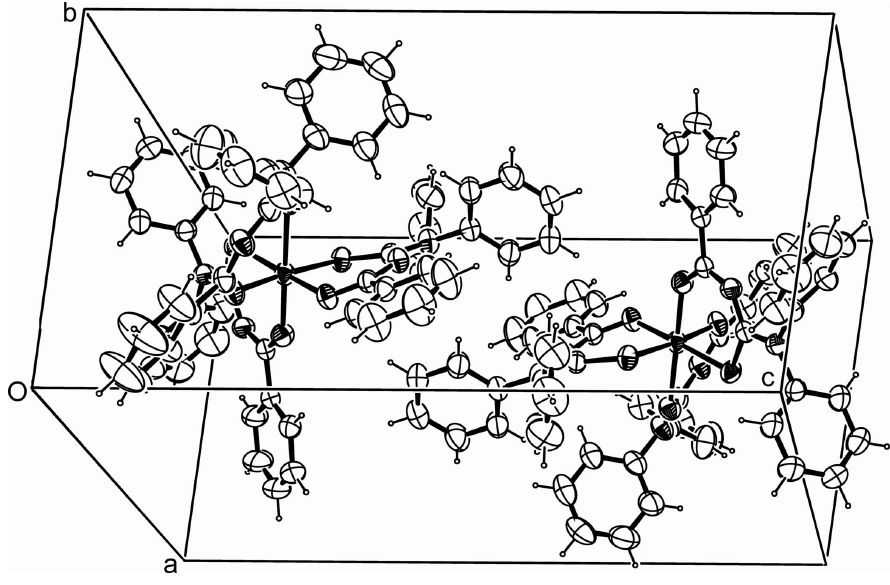
Figure 2 View of the unit cell of the title